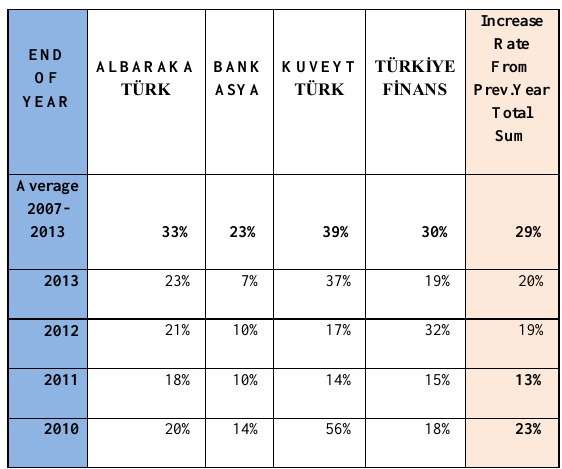
Table-14/b: Increase Rate from Previous Year at Equity Capital, 2007-2013